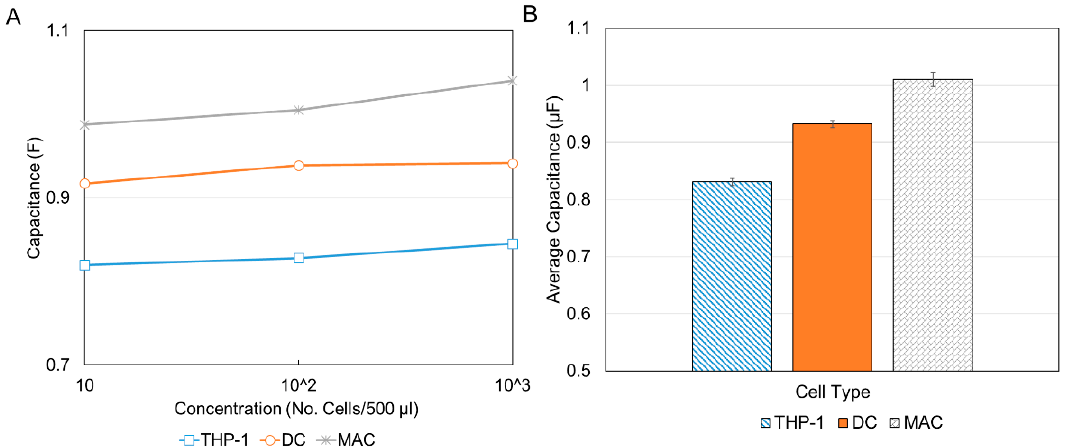
Figure 10. Capacitance vs. concentration for the three types of cells after the de-embedding process. ( A ) Capacitance versus concentration at 29.2 s where maximum capacitance occurs for each of the cell types. ( B ) Average capacitance for the three concentrations with S.E.M error bars. MACs had the highest values and DCs had the lowest values, consistent with the